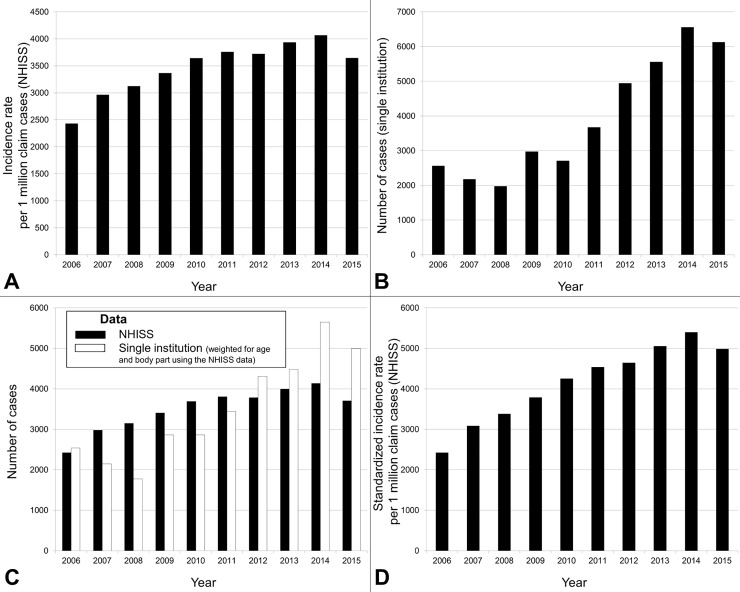
(A) Korean National Health Insurance Sharing Service (NHISS) data for the injury incidence rate per 1 million claim cases according to year. The incidence rate tended to increase during the 10-year study period (β = 0.877, p = 0.001). The decrease in 2015 may be explained by the outbreak of Middle East respiratory syndrome, when there was an attempt to reduce emergency department visits to prevent the spread of the virus. (B) Single-institutional data for visiting patients by year. The number of injured patients tended to increase over the study period (β = 0.933, p < 0.001) with more rapid changes occurring after 2010, which coincides with the opening of a pediatric emergency center in December of that year. (C) When the numbers of cases of single-institutional data were weighted for age and body part using the NHISS data, there was a greater increase in the single-institutional data. (D) NHISS data for the standardized injury incidence rate per 1 million claim cases by year. Although there appeared to be a greater increase in the single-institutional data in Fig 2C, the rate of increase in the NHISS data became more rapid after standardization to the population composition in 2006 (β = 0.964, p < 0.001). Despite a decreased proportion of children aged 0–14 years, the injury incidence rate increased over time. Therefore, the rate of pediatric traumatic injuries may have increased more rapidly than assumed.